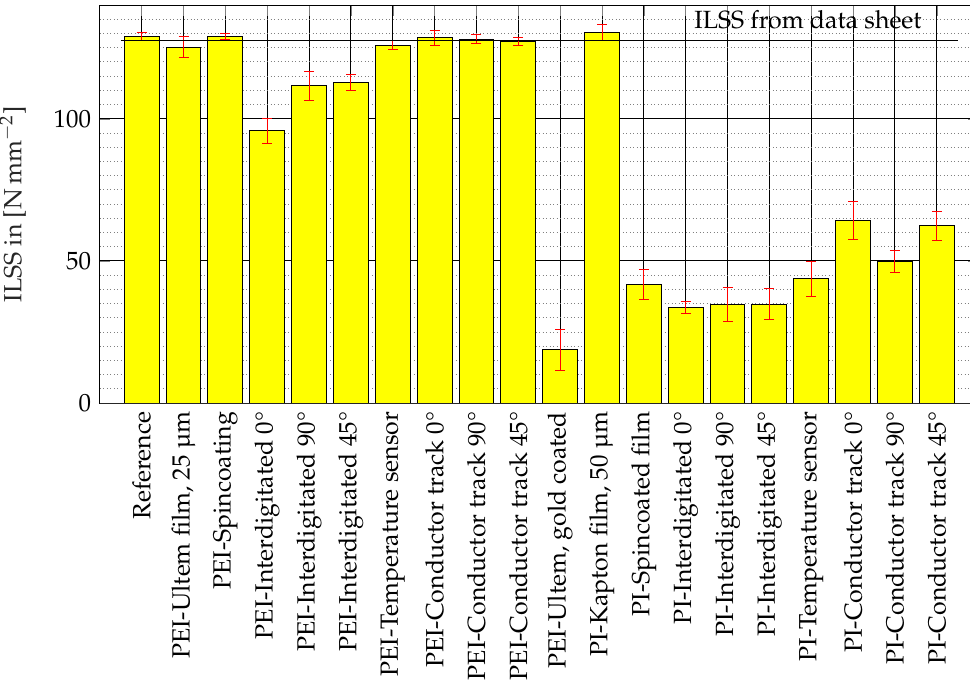
Figure 8. Comparison of the ILSS of different specimen series. The data on the ILSS of specimens with integrated 25 µm Ultem film (PEI) and gold-coated Ultem film comes from